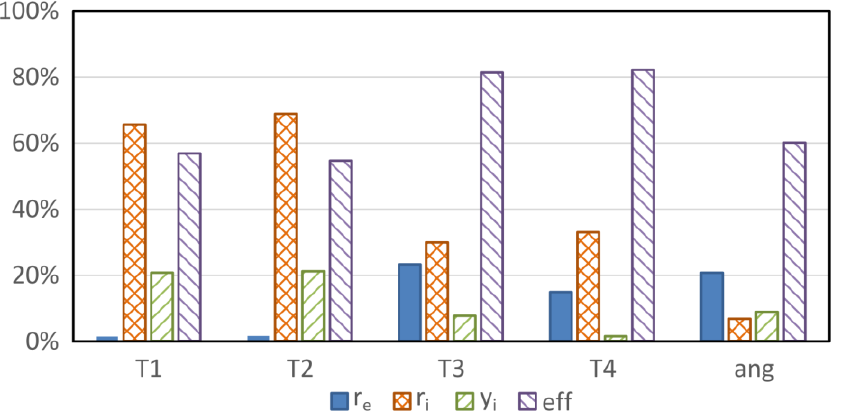
Figure 9. Correlations between inputs and outputs.